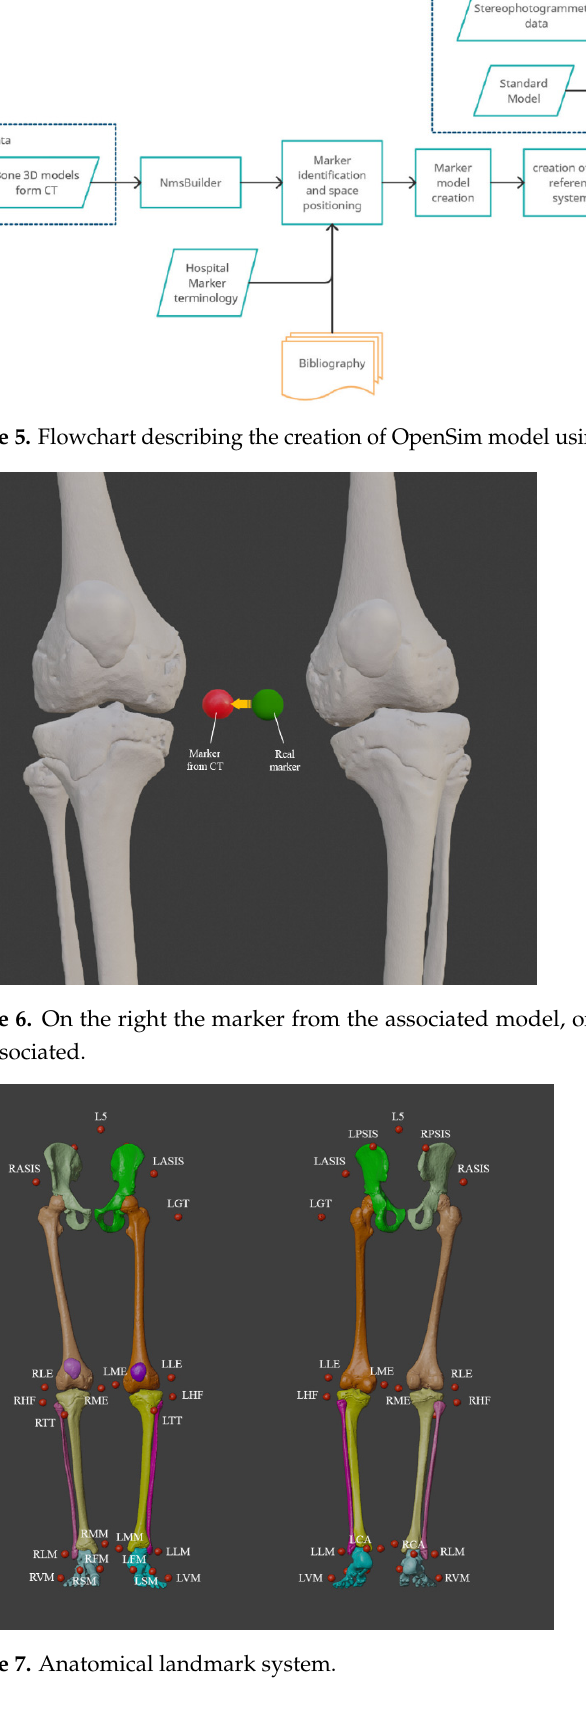
Figure 7. Anatomical landmark system.